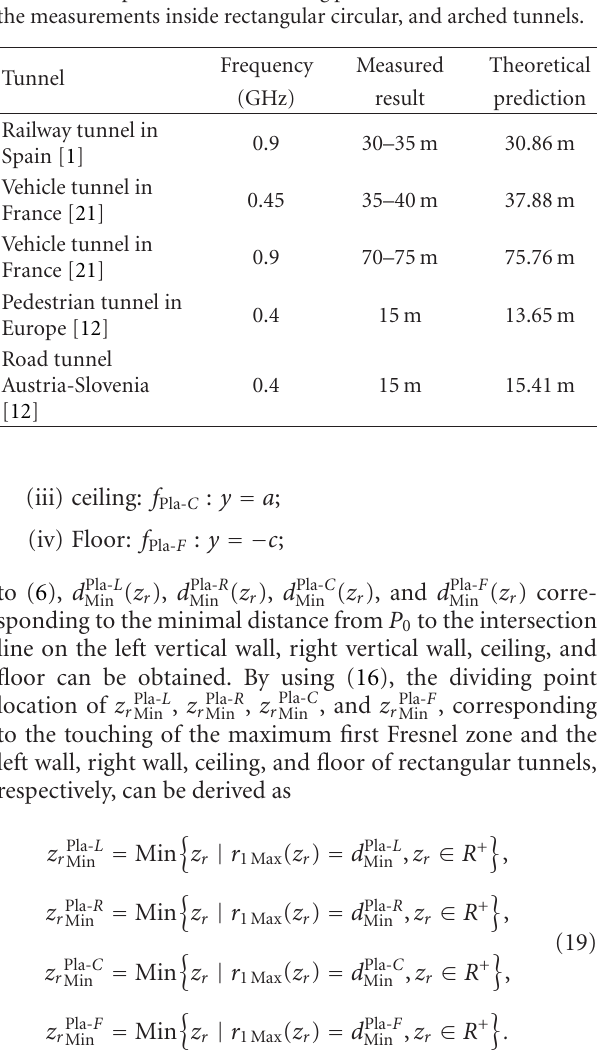
Table 1: Comparisons of the dividing point between the model, and the measurements inside rectangular circular, and arched tunnels.